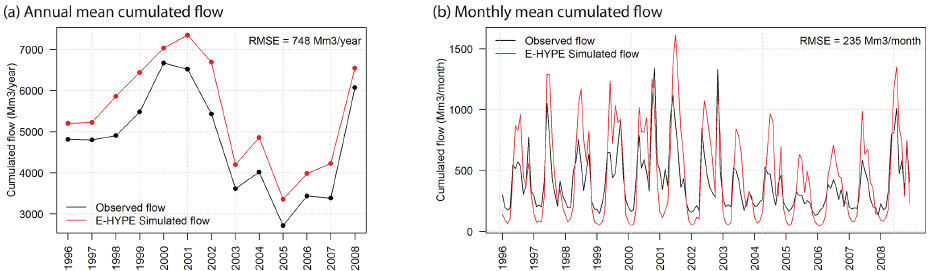
Figure 3. Annual mean accumulated flow (a) and monthly mean accumulated flow from observations and E-HYPE simulations from 1996 to 2008 (b)